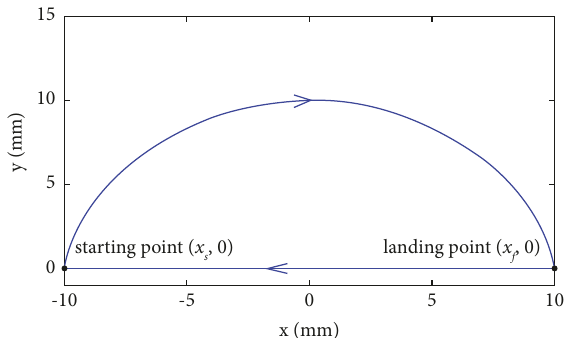
Figure 7: The cycloid trajectory of foot-end.